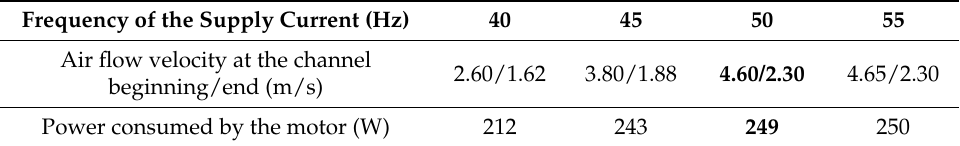
Table 1. Results of measurements. Bold fonts indicate the nominal current frequency.